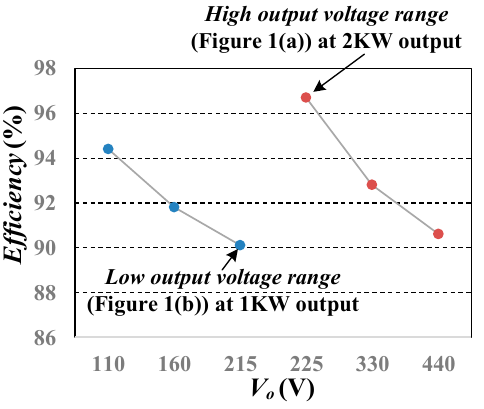
Figure 11. Measured circuit efficiencies of the proposed converter under different output voltages and the rated power.